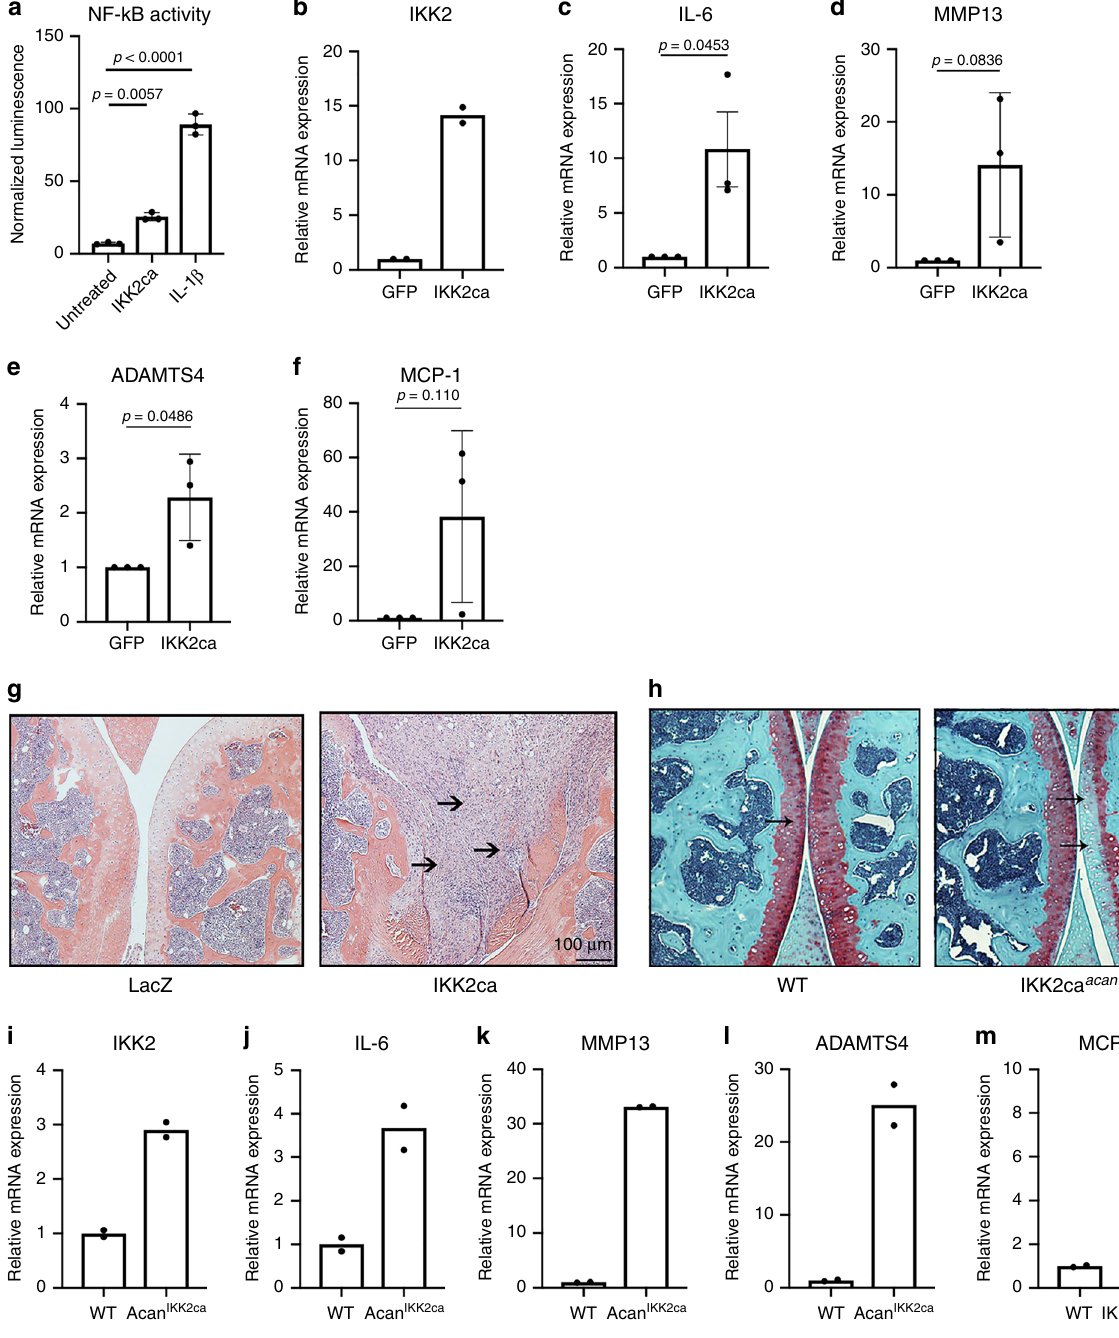
Fig. 3 NF- κ B activation in chondrocytes promotes catabolic changes. a Primary chondrocytes isolated from RelA-Luc reporter mice were either treated with IL-1 β (10 ng/mL) for 24 h or transduced with pMX-IKK2ca followed by luciferase assay, displaying NF- κ B activation, normalized to protein levels. Bar graphs display mean ± S.D. of n = 3 wells. Data is representative of one of three independent experiments. b – f Primary chondrocyte isolated from wild-type mice were transduced with pMX-GFP or pMX-IKK2ca and cultured for 24 h. qPCR was performed to measure gene expression. Bars represent mean ± S.E. M. for n = 3 independent experiments. Two-tailed Student ’ s t -test was utilized for statistical analysis, with p- values displayed in fi gure. g Six-week-old C57BL/6 mice were injected with Adeno-LacZ (left knee joint) and adeno-IKK2ca (right knee joint) ( n = 5 males). Animals were sacri fi ced after 10 days of injection and knee joints were isolated for analysis. Representative image from one mouse of H&E staining of Ad-LacZ and Ad-IKK2ca injected joints re fl ects changes seen in all mice. h 12-week-old Agn1 CreERT2 , IKK2ca ki/ki (IKK2ca acan ) and littermate controls animals ( n = 6) mice were fed with tamoxifen diet (0.4 g/kg diet) for 2 months. At the end of the experiment, animals were sacri fi ced and knee joint tissue were harvested for further analysis. Representative image of Safranin-O staining from one mouse shows loss of articular cartilage and proteoglycans in IKK2ca acan mice compared to littermate controls. i – m Gene expression measurement from mRNA isolated from pooled articular cartilage of IKK2ca acan mice ( n = 3) compared to control mice ( n = 3), due to small size of tissue sample. Representative data from one experiment out of two, with bars representing mean of technical